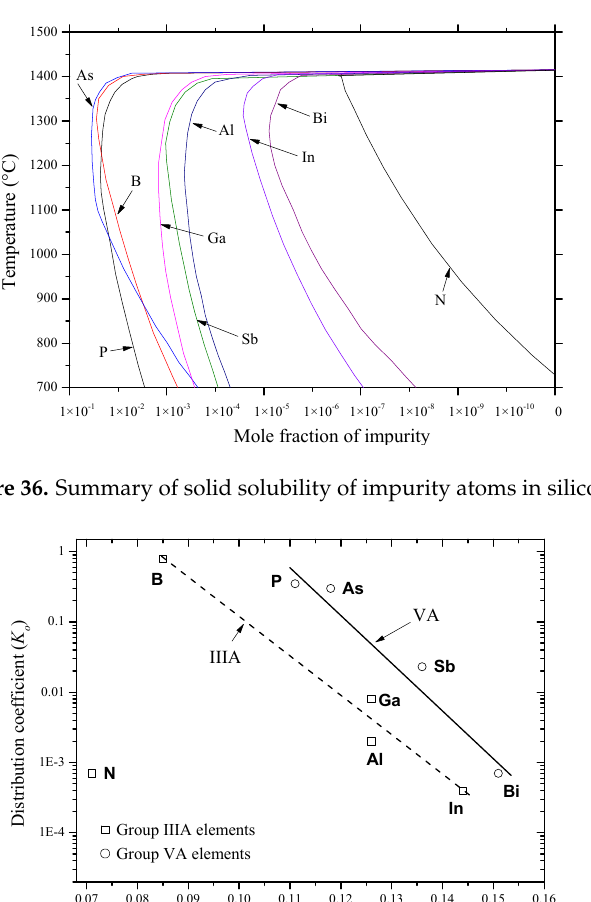
Figure 38. Summary of diffusivity of the studied elements in silicon. The parameters used in the diffusion equation are listed in the embedded table.